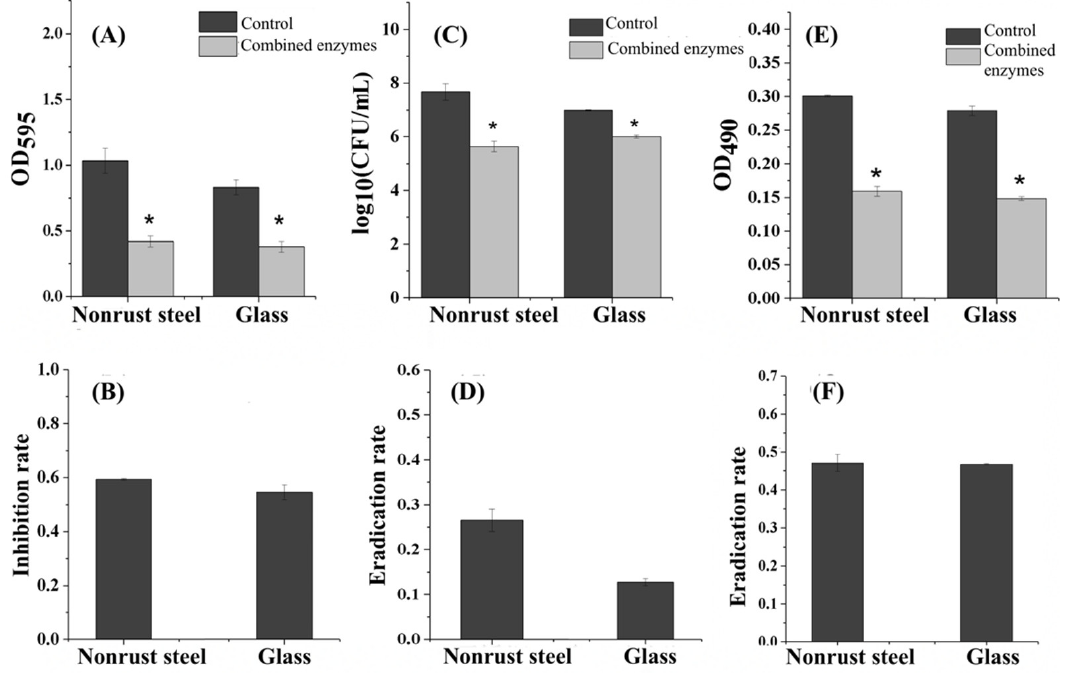
Figure 6. Effect of combined enzymes for biofilm eradication on different carriers: ( A , B ) inhibition effect; ( C , D ) the number of bacteria; ( E , F ) the content of extracellular polysaccharide. Three technical replicates and three biological replicates were conducted. In the figure, * represents a significant difference with p < 0.05 .